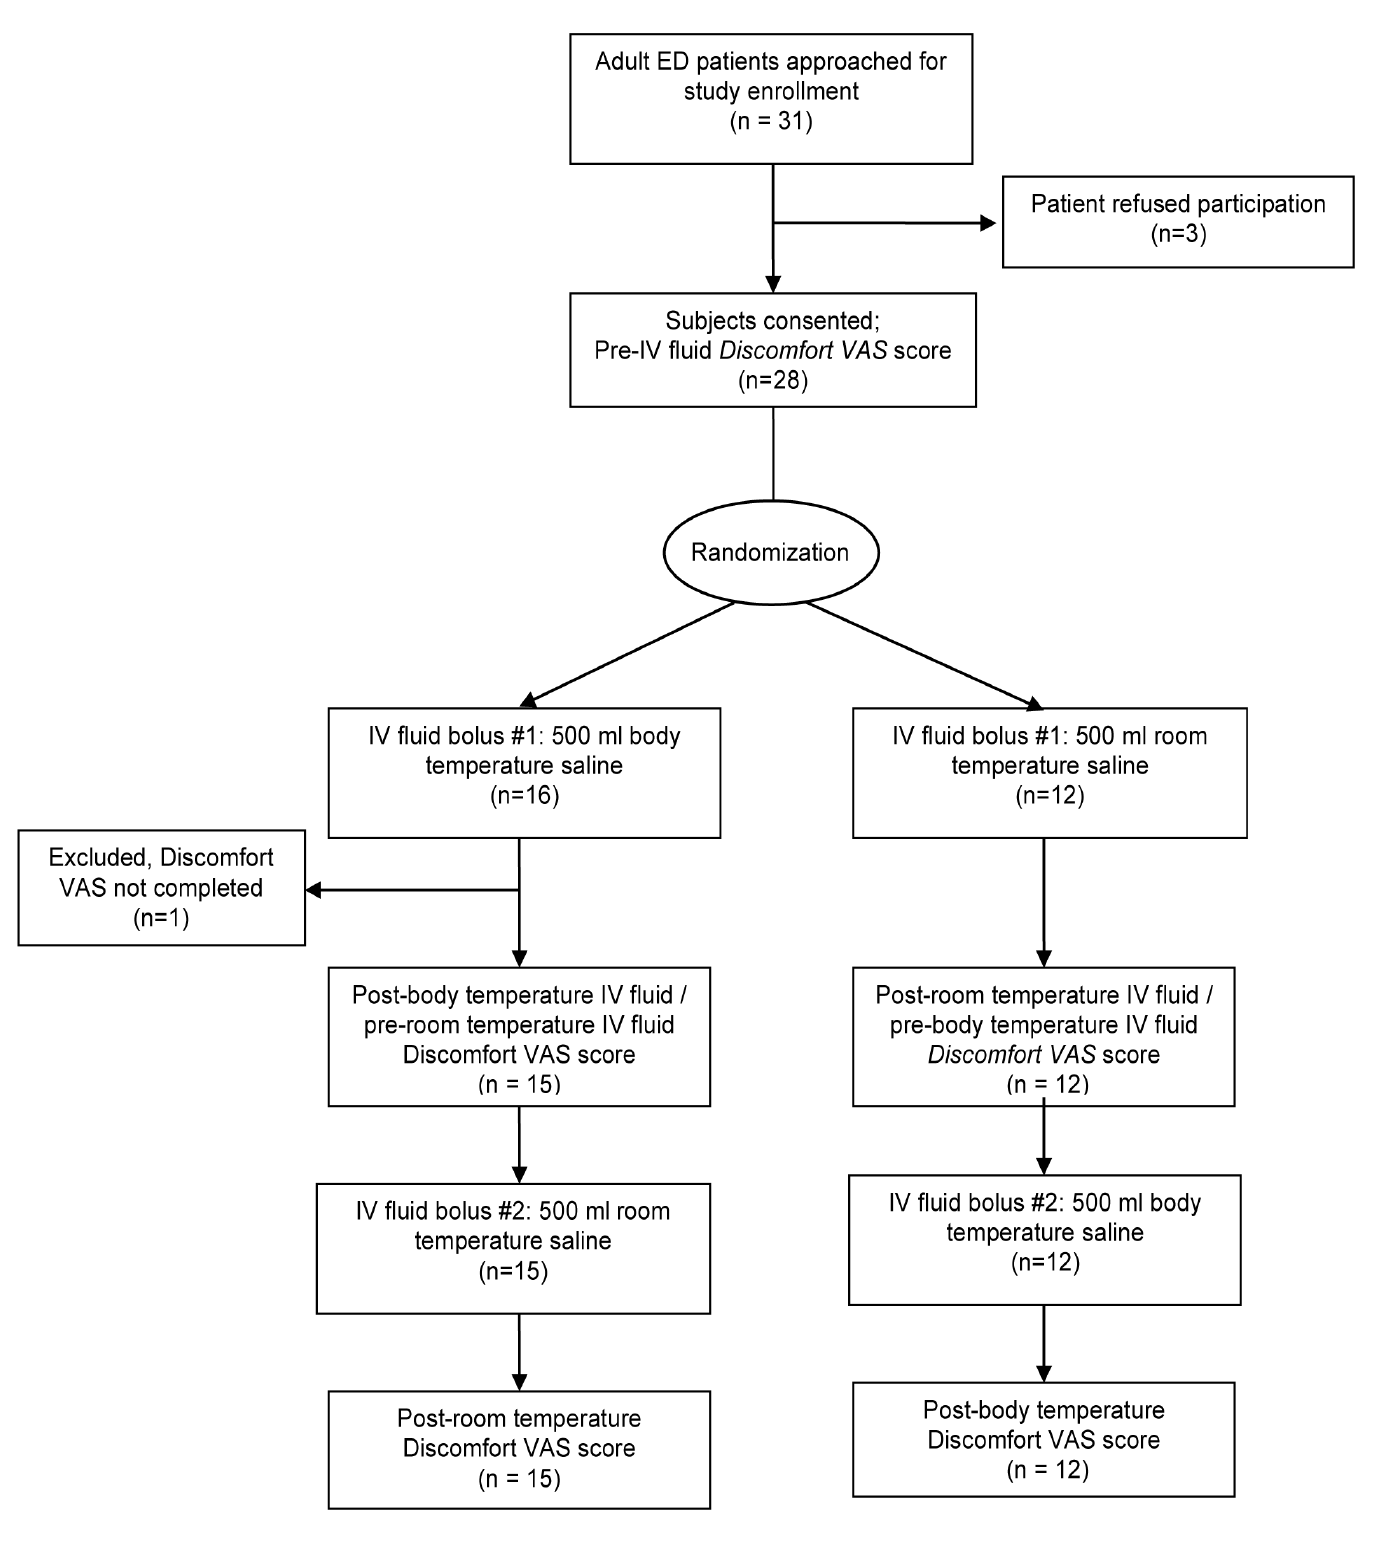
Figure 1. Flow diagram of subject